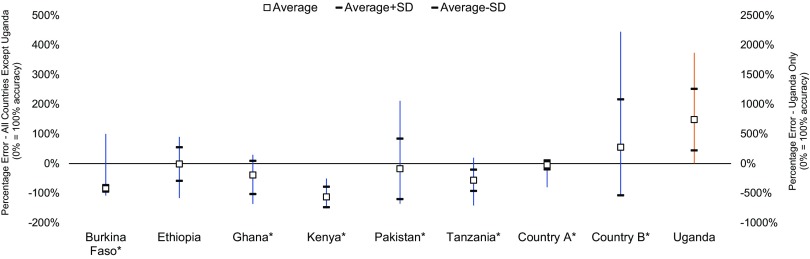
Procurement Quantity Accuracy Based on Maximum Quantities Required to Fill the Supply ChainAbbreviation: SD, standard deviation (average + SD is shown with the top horizontal line while average − SD is shown with the lower horizontal line).Note: Uganda, which appears to have a very high overstocking of implants, is plotted on a separate, secondary y-axis to avoid obscuring the differences for the other countries.*Dispensed-to-client data were incorporated in the analysis.